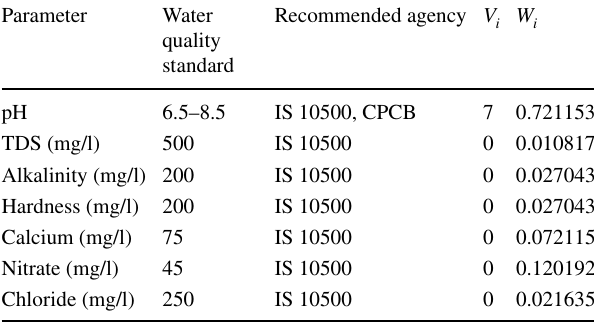
Table 2 Selected values for water quality index calculation